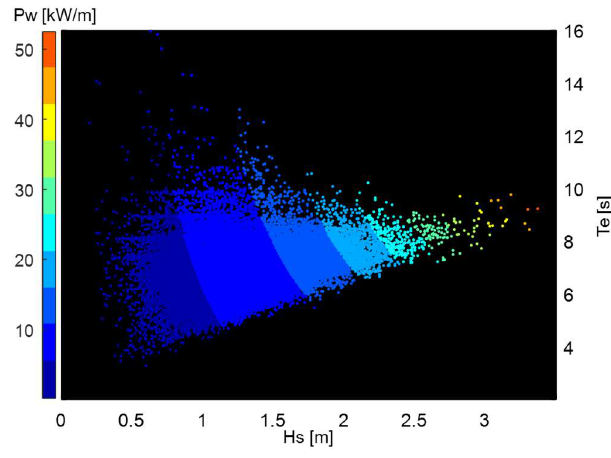
Figure 5. Combined scatter plot showing the occurrence of H s , T e and P w in Kilifi.